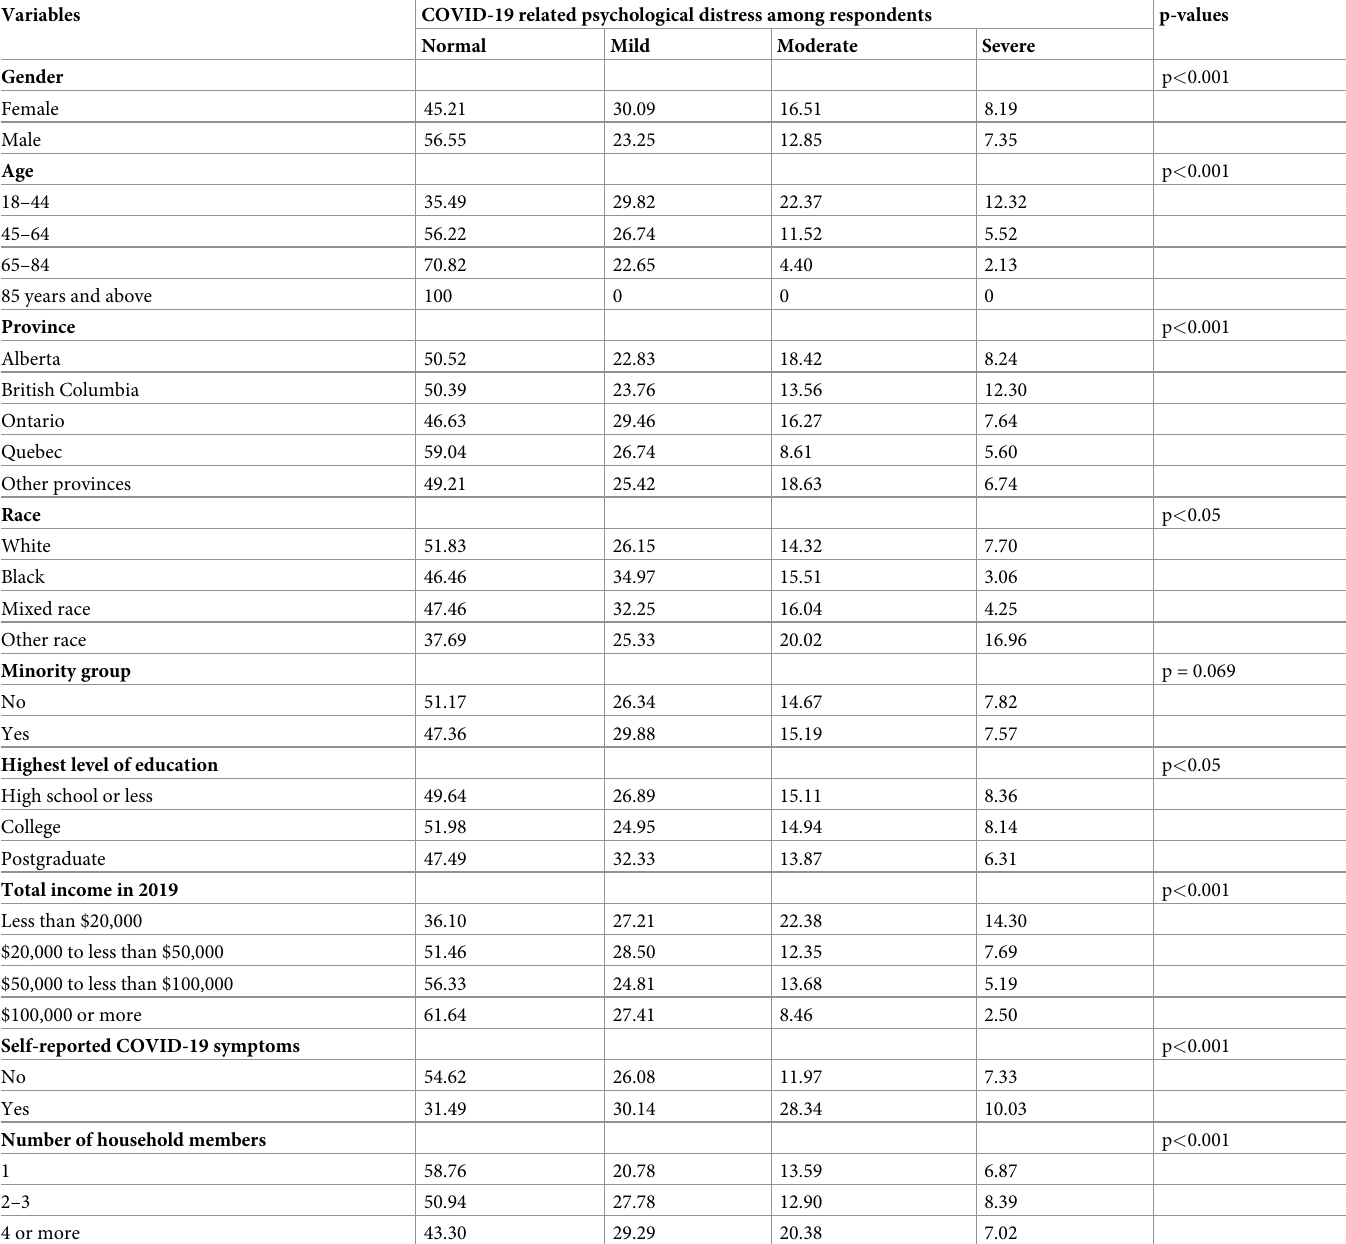
Table 2. Distribution of psychological distress across socioeconomic and demographic factors of respondents.